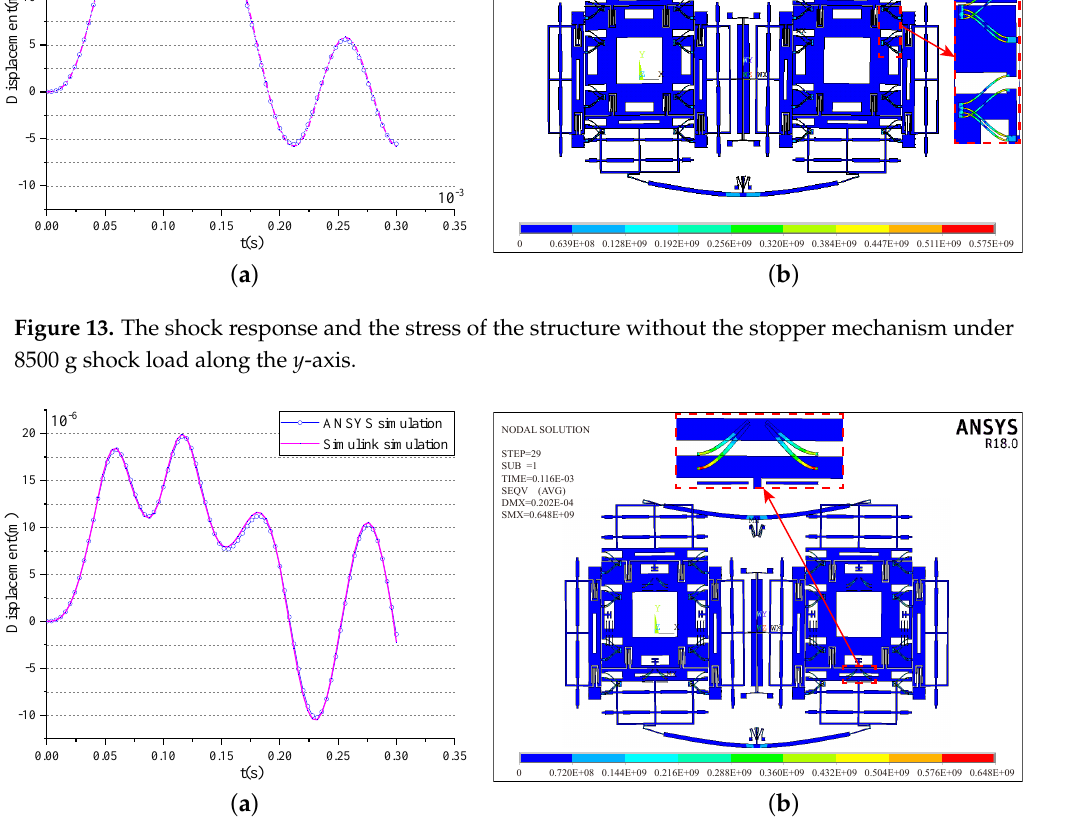
Figure 14. The shock response and the stress of the structure with the two-stage elastic stopper mechanism under 10,000 g shock load along the y -axis.